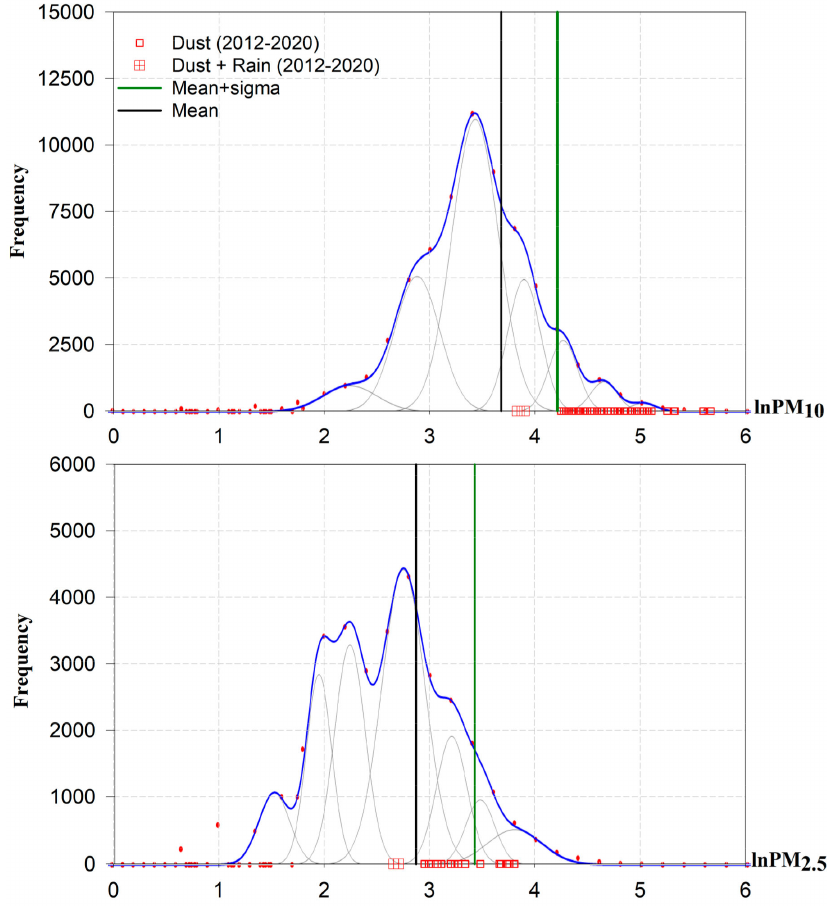
Figure 6. Frequency distributions of PM 10 and PM 2.5 mass concentrations for the measurements during January 2012–December 2020. Mass concentrations are given as ln values in x-axis. The green lines stand for mean + SD and the black line is marked mean value. The individual samples collected during dust are marked as square symbols along the x-axis. Dust + Rain means that dust event and rain happened together, where rain was as recorded by the